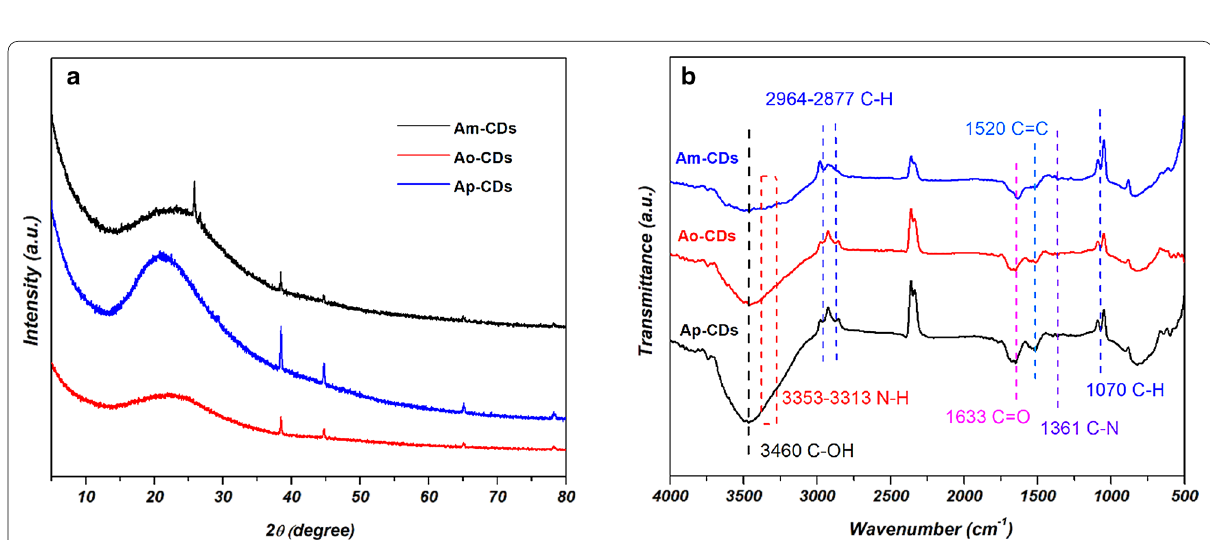
Fig. 5 a XRD patterns, and b FTIR spectra of A x